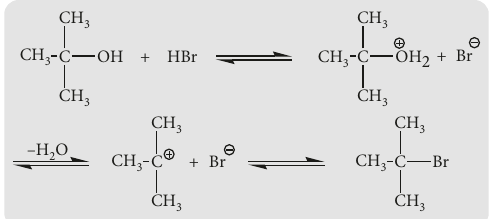
Figure 3: Substitution as a competitive reaction [47].